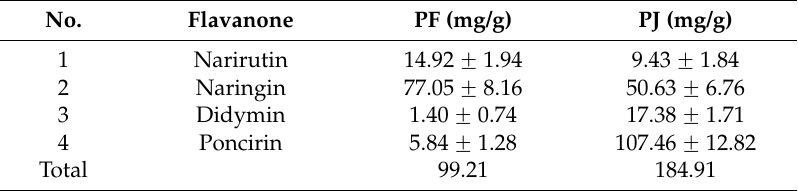
Table 2. Contents of four main flavanones in P. trifoliata flavedo (PF) and juice sacs (PJ) extracts.